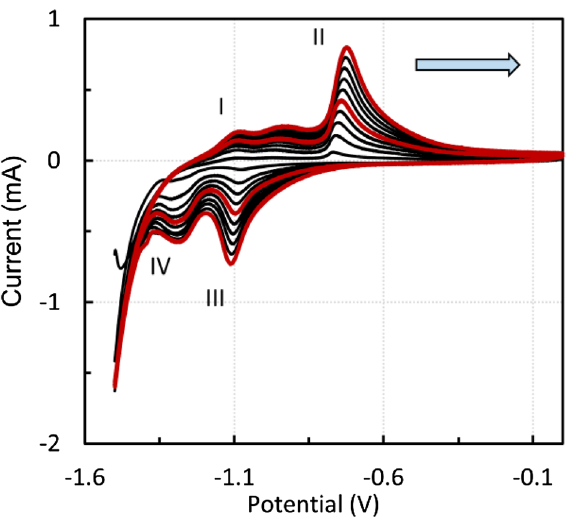
Figure 6. Voltammogram of CPE modified by the sludge residue after leaching in the 0.01 M acetic acid solution, 1 M NaOH, scan rate 10 mV s −1 , positive direction, every fifth cycle is marked in